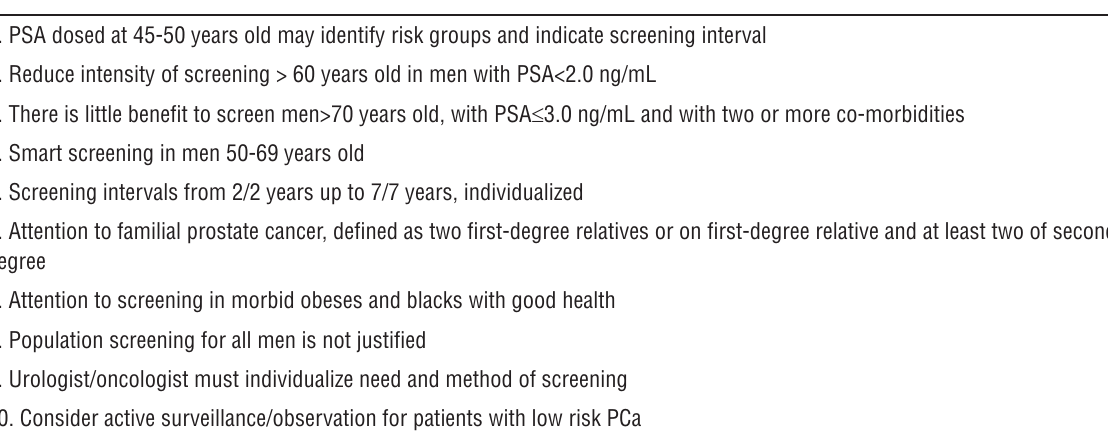
Table 3 - general measures that may help define guidelines for prostate cancer